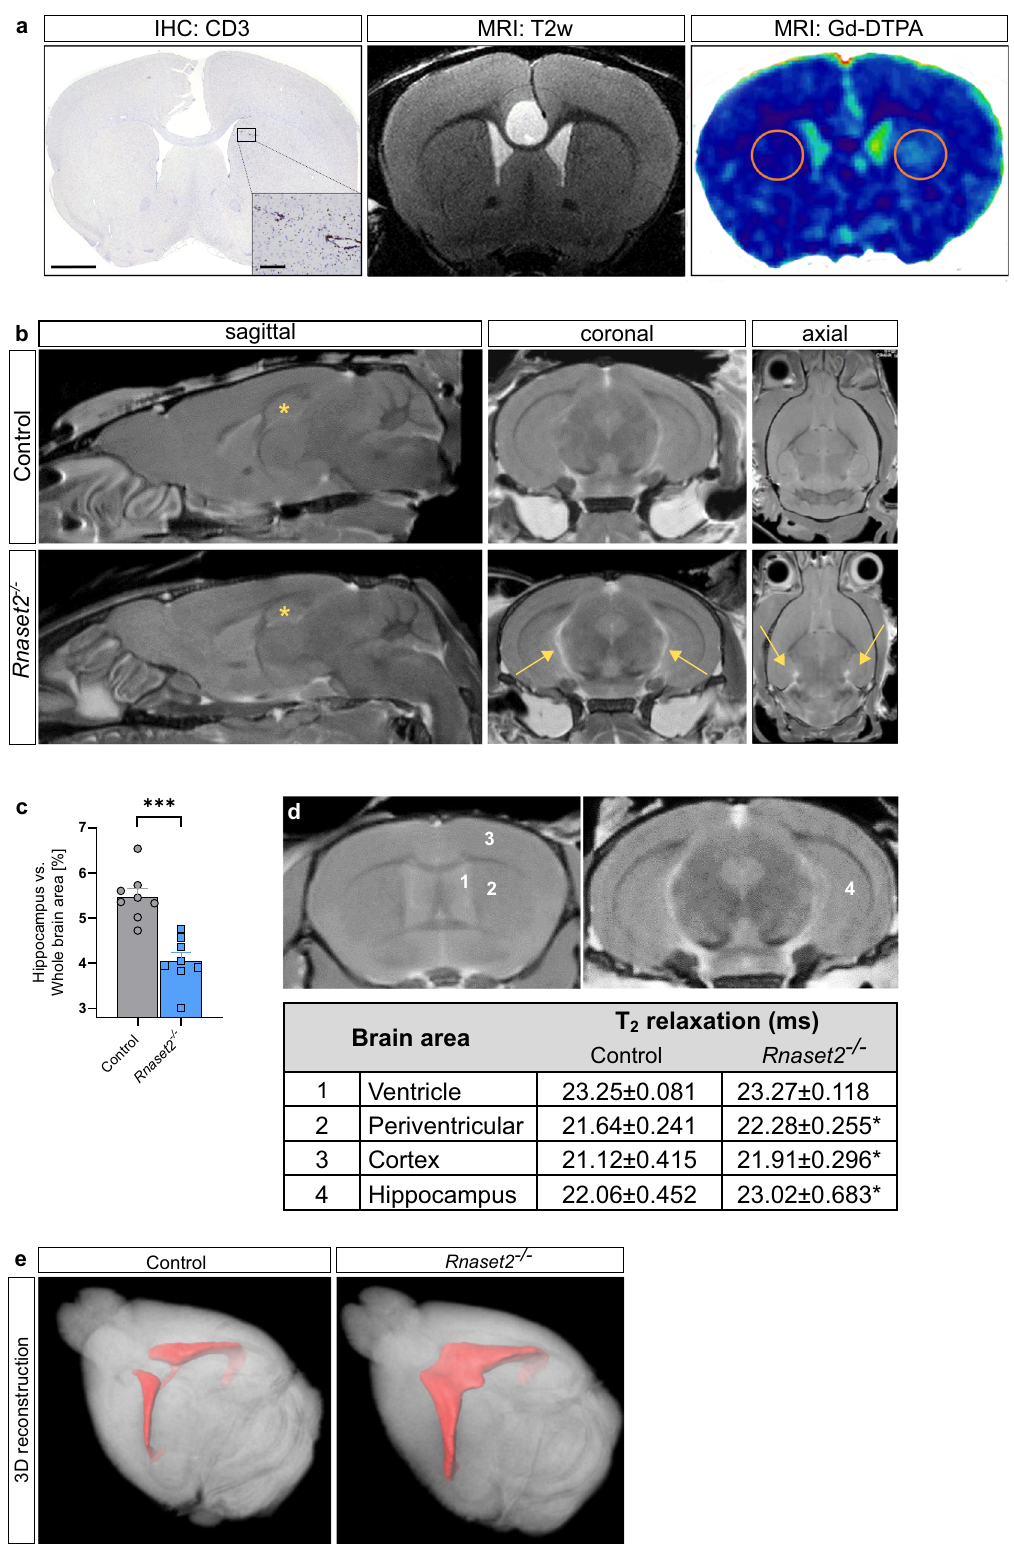
by gadolinium enhancement on cerebral MRI. Furthermore, the observed neuroin fl ammation might foster the documented gen- eral brain atrophy, which is accentuated in the hippocampus. Not surprisingly, memory function is impaired in these